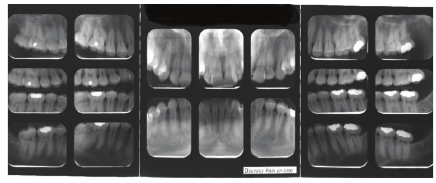
Figure 6: Initial full mouth